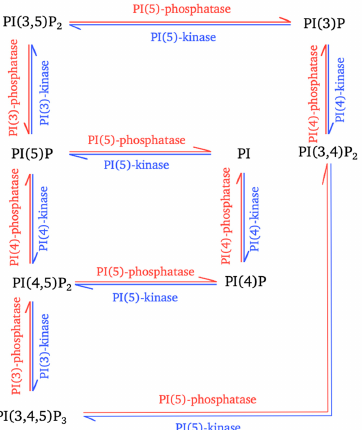
Figure 1. Interconversion of phosphoinositides mediated by cellular enzymes. The interconversion reactions for the controlled production of the seven types of phosphoinositides (PPIns) are shown. These reactions involve di ff erent phosphatidylinositol kinases (blue arrows) and phosphatidylinositol phosphatases (red arrows). Viruses 2020 , 12 , x FOR PEER REVIEW